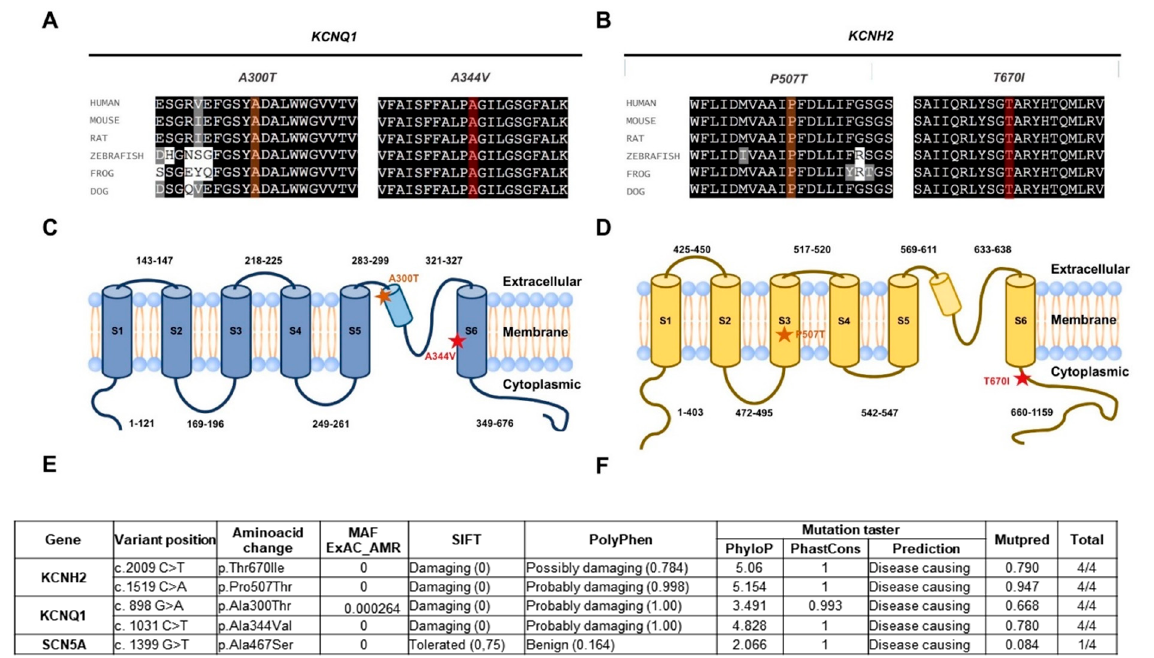
Figure 2. Sequence conservation, location, and predicted consequence of variants identified in the patients. Patient 1 ( A , C ) and Patient 2 ( B , D ). The predicted aminoacids ( A , B ) and the location ( C , D , stars) of each variant are shown in orange and red. Conservative substitutions are shown in grey and non-conservative substitutions are shown in white. Location of variant residues from patients 1 and 2, respectively, in protein schematics depicting secondary structure. ( E , F ) Results of pathogenicity prediction analyses from SIFT, PolyPhen Mutation Taster, and Mutpred for all variants identified in these patients.